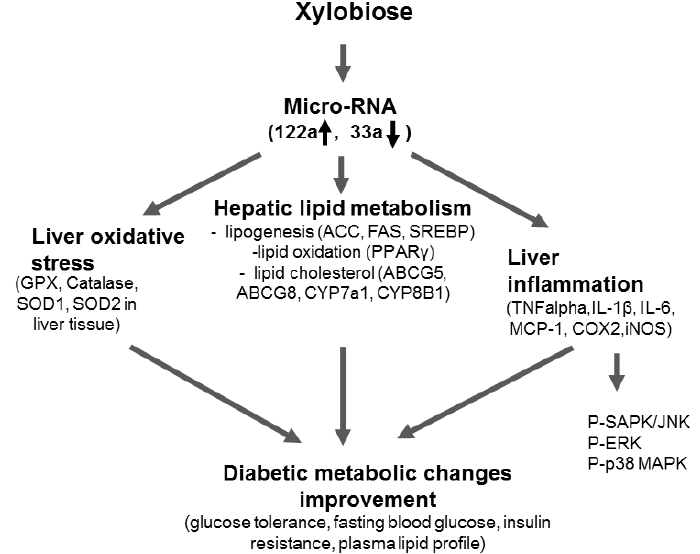
Figure 8. Proposed mechanism of xylobiose-regulated metabolic changes in diabetes. Xylobiose supplementation regulates the miR-122a/miR-33a axis, which in turn may regulate various lipogenesis and cholesterol homeostasis involved genes, including FAS, SREBP-1c, PPAR γ , ACC, ABCG5, ABCG8, CYP7A1, and CYP8B1. In addition, xylobiose supplementation regulates oxidative stress by inhibiting the upregulation of antioxidant enzymes such as SOD1, SOD2, catalase, and GPX, while decreasing the expression of genes related to the hepatic inflammatory response by regulating phosphorylation of